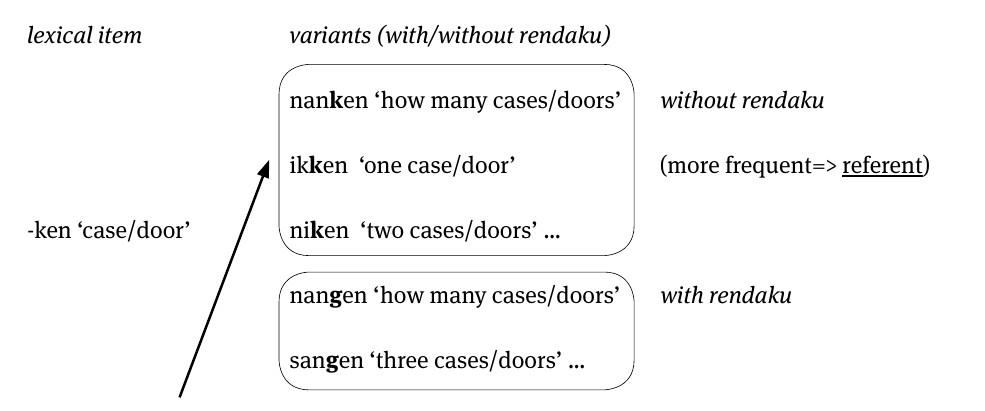
Figure 2: Analogy-based model with lexical frequency